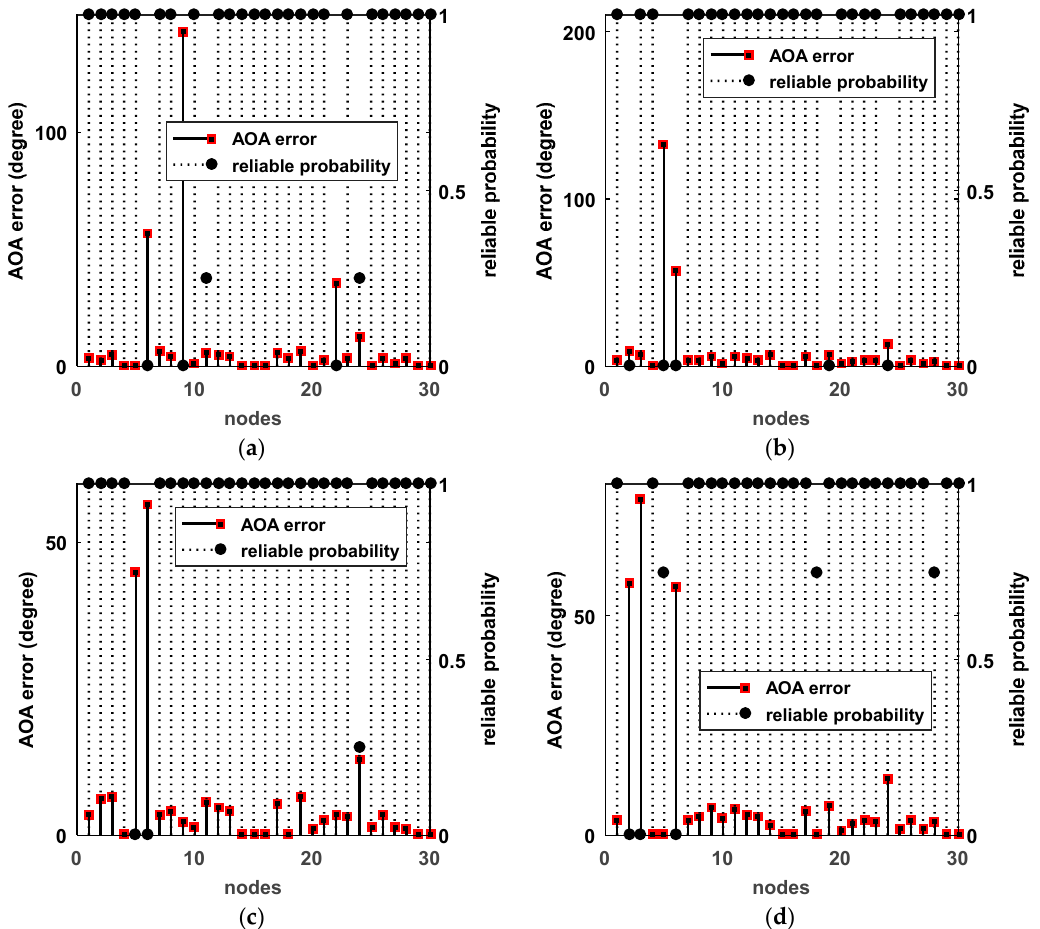
Figure 14. Estimated AOA errors and unreliable sensor detection results. ( a ) The 11th experiment; ( b ) the 33rd experiment; ( c ) the 10th experiment; ( d ) the 32nd experiment. As nodes,